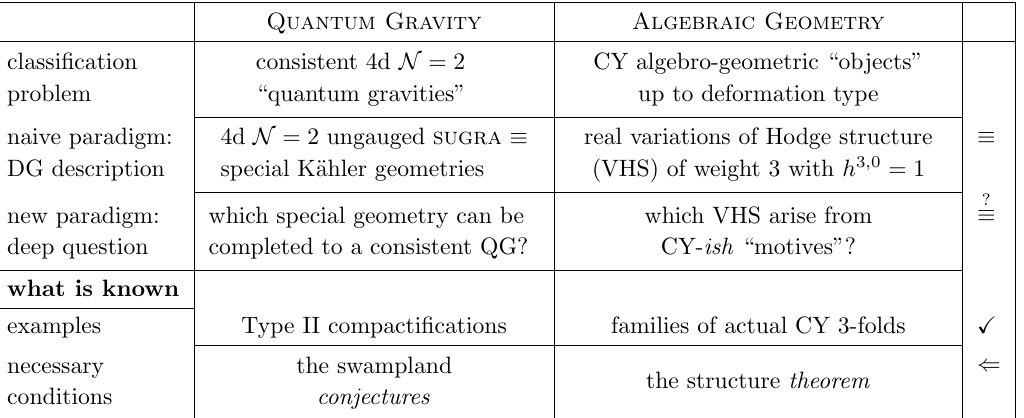
Table 1 . The comparison of two classi(cid:12)cation problems. Symbols in the right margin describe the logical relation between the two boxes in the same row: (cid:17) means that the two are known to be ? strictly equivalent, (cid:17) means that the two are conjectured to be equivalent, while X means that the two are trivially the same; (cid:12)nally, ( means that the statement in the second column implies the ones in the (cid:12)rst